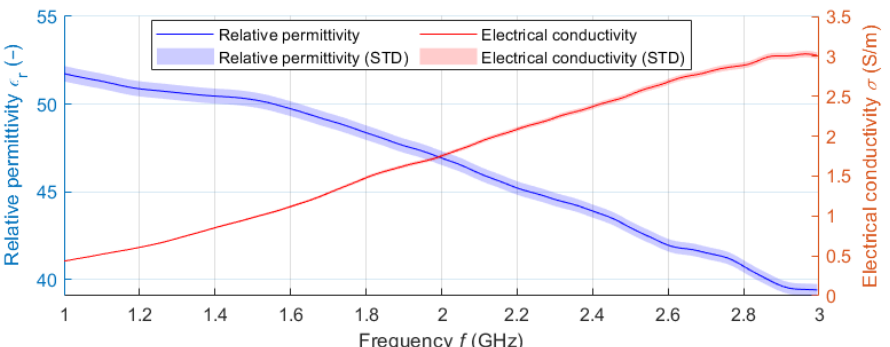
Figure 9. Measured frequency dependence of the dielectric parameters of the liquid liver phantom. The values are supplemented with a confidence interval corresponding to the expanded measure- ment uncertainty.